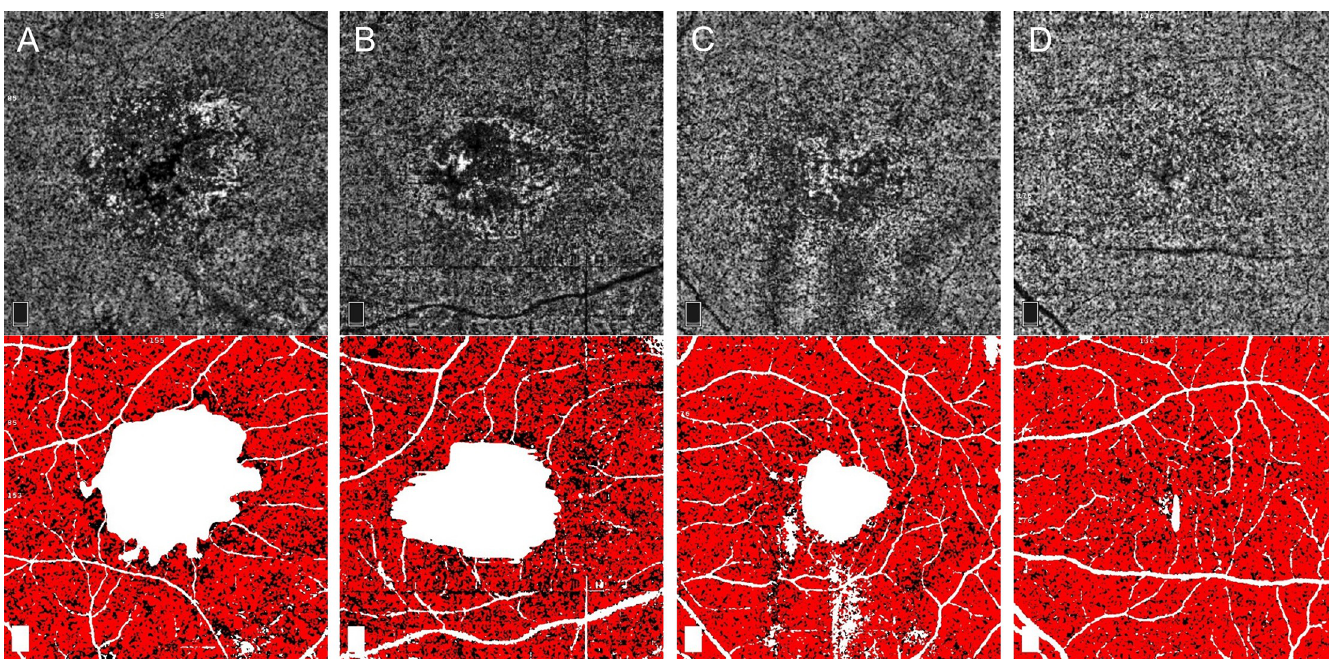
Fig 5. Representative cases illustrating en face OCT angiography of the choriocapillaris slab (top row) and the final image created to calculate the percentage of choriocapillaris area of nonperfusion (PCAN) (bottom row) in each group. A, Right eye of a 73-year-old male in TEq4-6w group with type 1+2 choroidal neovascularization (CNV). PCAN is 26%. B, Right eye of an 82-year-old male in TEq7-12w group with type 1 CNV. PCAN is 33%. C, Left eye of an 80-year-old male in PRN > 12mo group with type 1 CNV. PCAN is 19%. D, Left eye of a 79-year-old male in the fellow-eye group without a clinical diagnosis of CNV. PCAN is 15%.